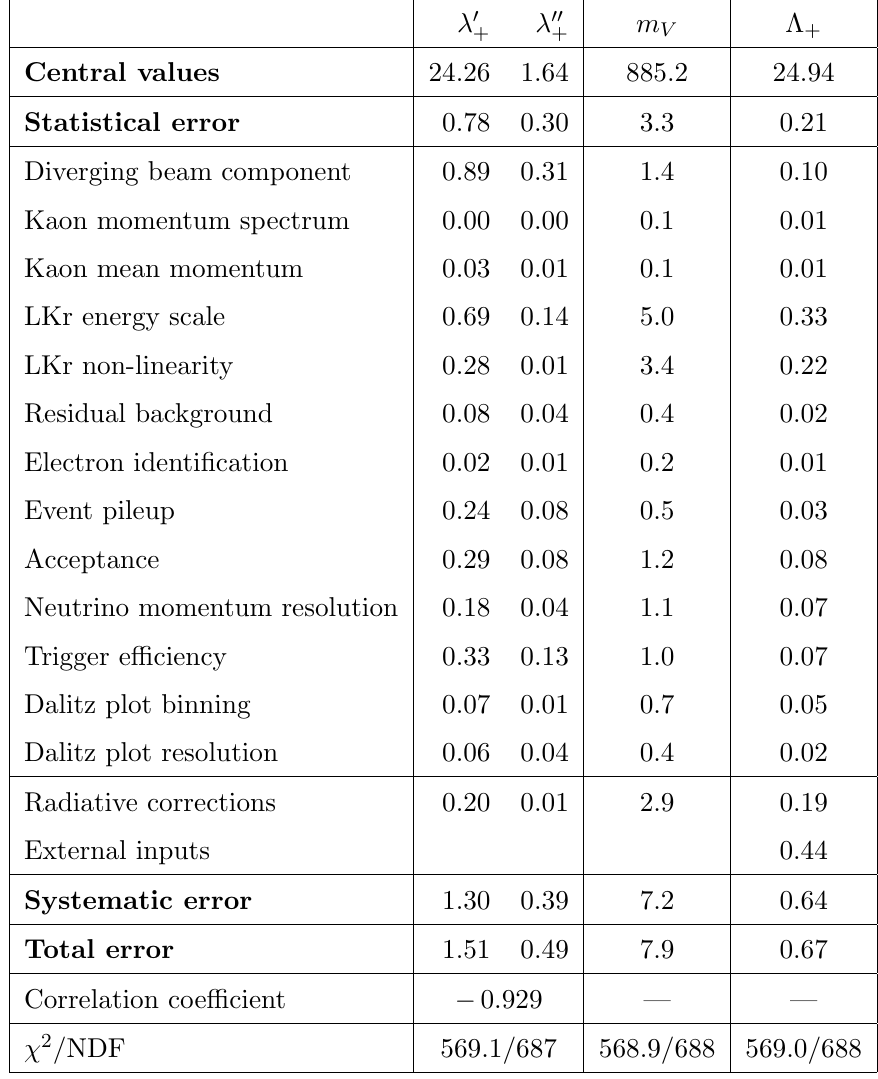
Table 3 . Form factor results of the K (cid:6) systematic uncertainties. The units of (cid:21) 0 value and error are MeV = c 2